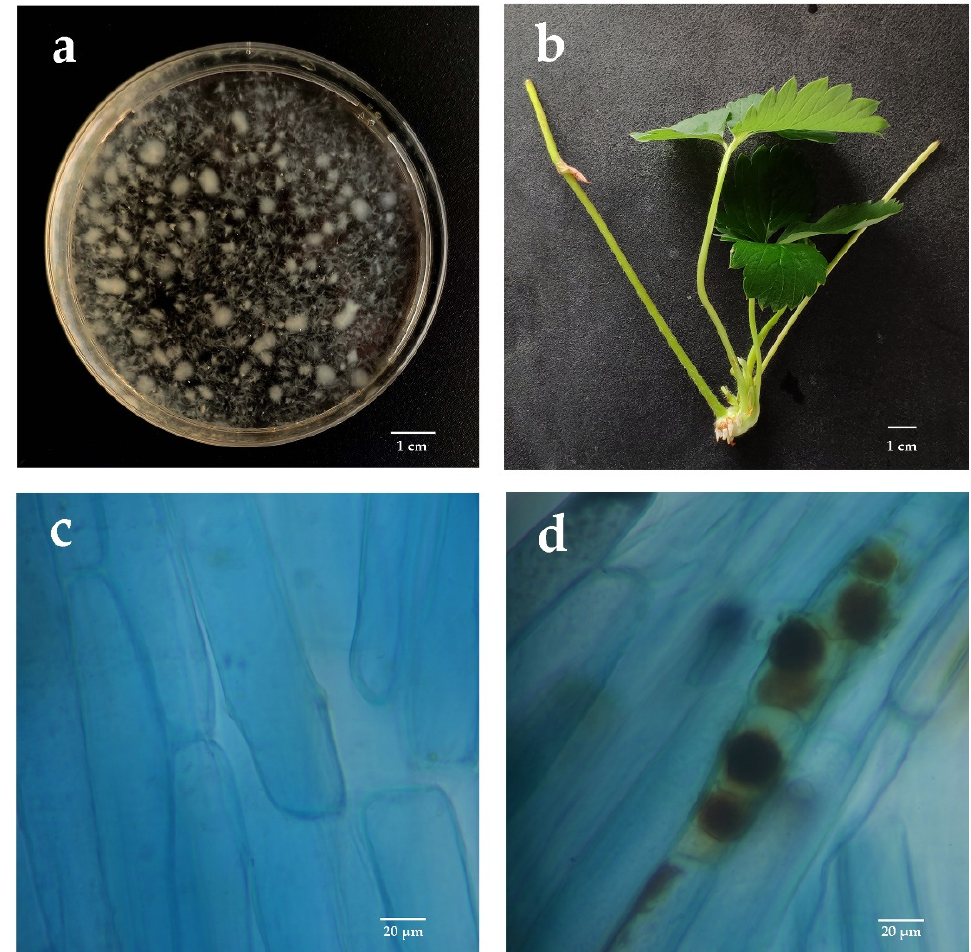
Figure 1. P. indica colonization in roots of strawberry cutting seedings. ( a ) Inoculation solution of P. indica ; ( b ) Typical strawberry daughter plants used in this study; ( c ) Root cells without P. indica colonization; ( d ) Root cells with P. indica colonization. Table 1. Effects of P. indica on the growth-related parameters of ‘Benihoppe’ and ‘Sweet Charlie’ daughter plants. CK: noncolonized control strawberry daughter plants; Pi: P. indica colonized strawberry seedlings; ‘*’ represents that the difference between P. indica colonized and noncolonized strawberry seedlings was significant (Student’s t -test, *, p < 0.05; n = 8). Benihoppe Sweet Charlie Growth Parameters CK Pi CK Pi Above-ground fresh weight